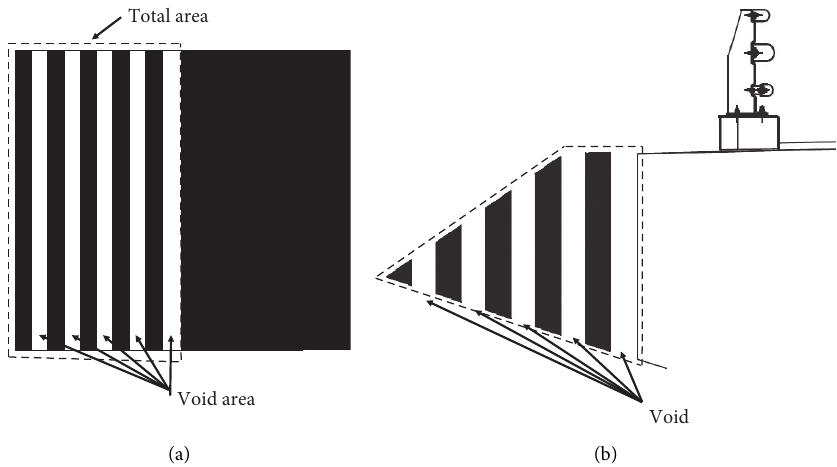
Figure 3: Definition of the wind penetration ratio: (a) plan view and (b) section view.